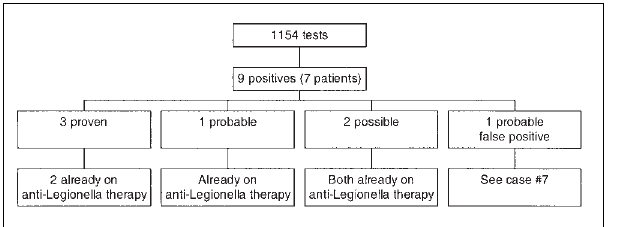
Figure 1) Patients with positive urinary antigen tests